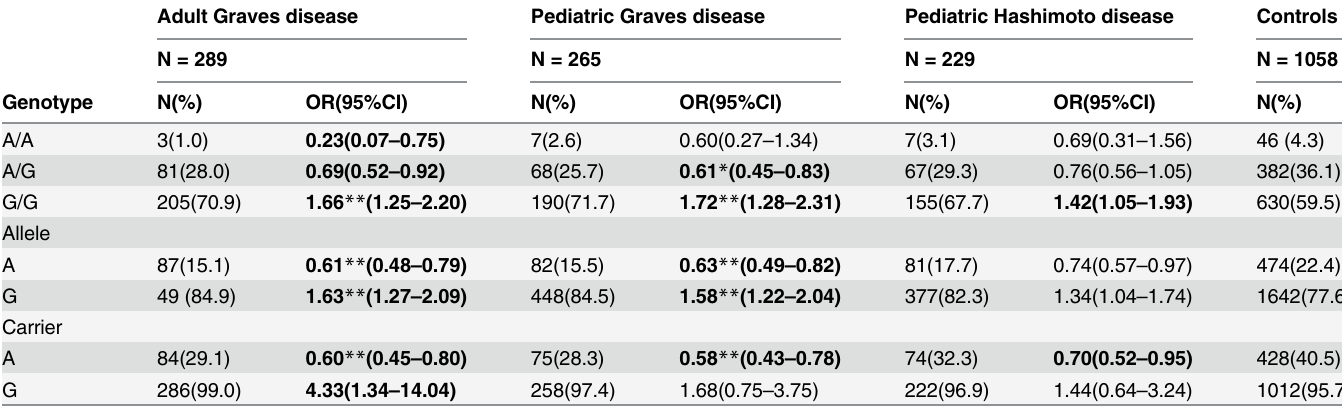
Table 3. Polymorphism of CT60 (rs3087243) of the CTLA4 gene in adult Graves disease, pediatric Graves disease, Hashimoto disease patients and